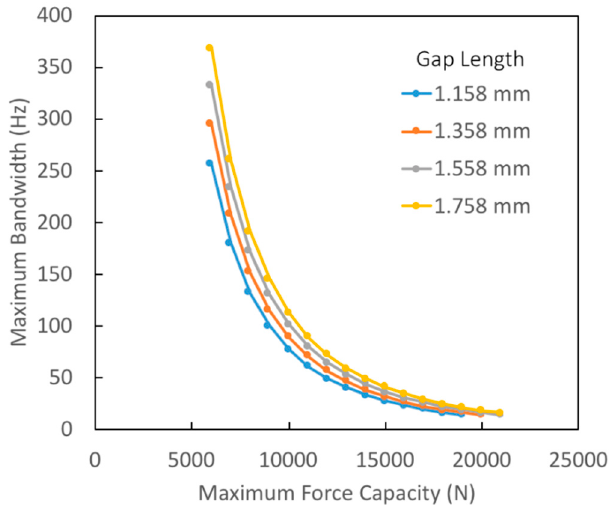
Figure 4. Pareto-optimal curves showing maximum achievable actuator bandwidth as a function of maximum force for various values of axial gap.